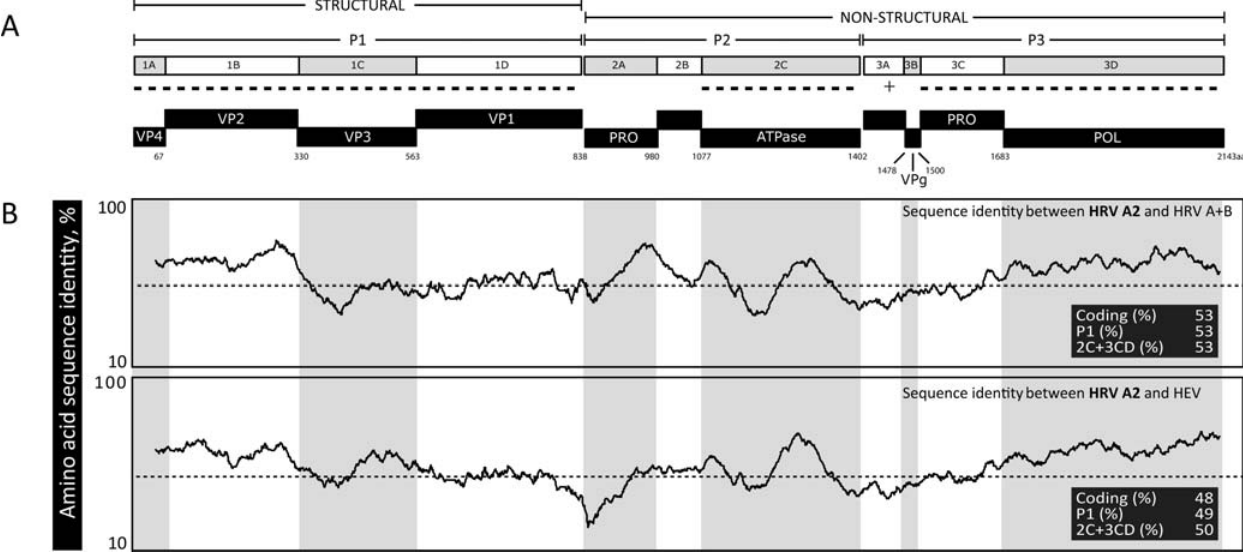
Figure 1. Characterization of HRV A2 genomes. (A) Scale representation of the coding region from prototype HRV A2 virus, HRV-QPM. Predicted protein products from the structural (VP4 to VP1) and non-structural (PRO-protease; POL-polymerase) regions are indicated. Regions are shaded alternatively for convenience and numbering indicates positions of predicted protease cleavage according to the start of the HRV-QPM polyprotein. Dashed lines indicate regions involved in species classifications. (B) HRV A2 amino acid similarity to HRV A (n=34) and B (n=13), or HEV (n=71) strains as determined by SimPlot (cid:1) analysis. Plots indicate the percentage similarity of a 50% consensus sequence from each species’ polyprotein compared to the HRV A2 strains. Average similarity across the polyprotein is indicated by dotted line. Averaged values for the complete coding, P1 and 2C + 3CD regions are indicated within the inset of each panel.